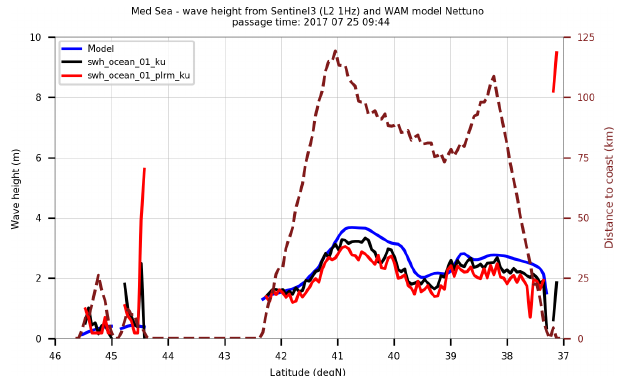
Figure 5. Inter-comparison, along the ground track in Fig. 4, of the model significant wave heights and the measurements (ku- and plrm-ku-corrected H s ) from the Sentinel-3 altimeter. The dashed line shows the distance in kilometres of each measurement from the closest coast.